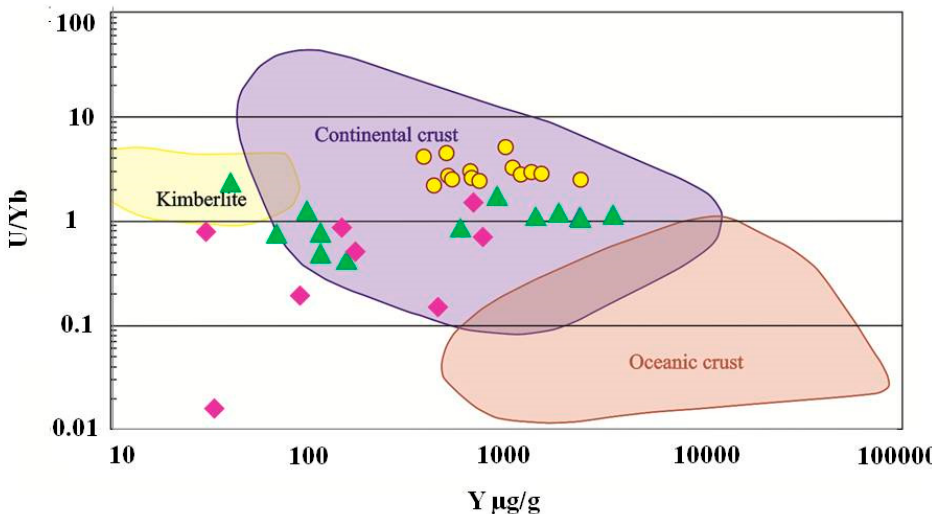
Figure 16. U/Nb vs. Y discriminant diagram of zircons from kyshtimtes (bold yellow circles), miascites (bold purple diamonds), and carbonatites (bold green triangles) of the Ilmenogorsky-Vishnevogorsky complex (the chemistry on miascites and carbonatites is modified after [45]). Fields for continental and oceanic crust, and kimberlite are from Grimes et al. (2007) [57].